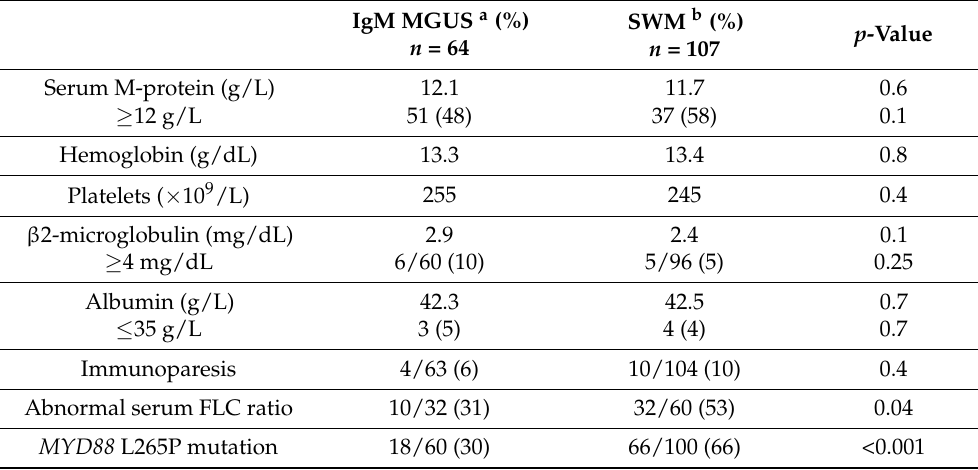
Table 2. Laboratory values in patients categorized by diagnosis (IgM MGUS or